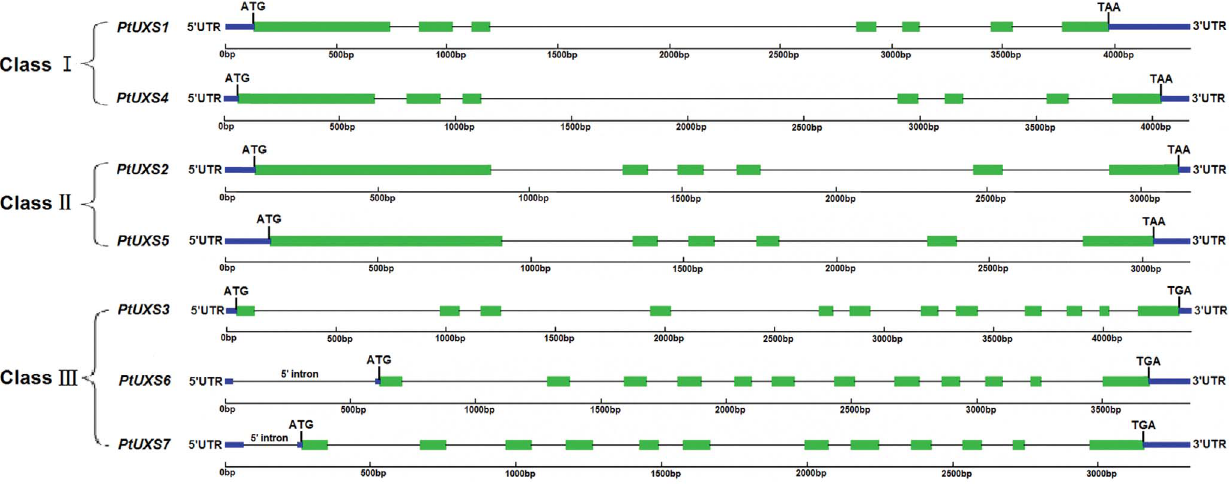
Figure 1. Genomic organization of PtUXSs . Three patterns of intron-exon structures of the PtUXS genes were identified and designated I, II and III. Exons and untranslated regions (UTRs) are shown as green and blue boxes, respectively, and the lines between boxes indicate